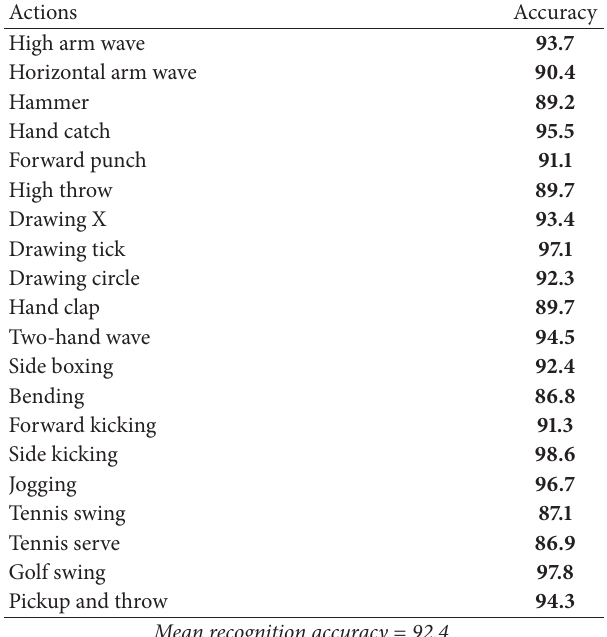
Table 2: Recognition results of proposed HAR